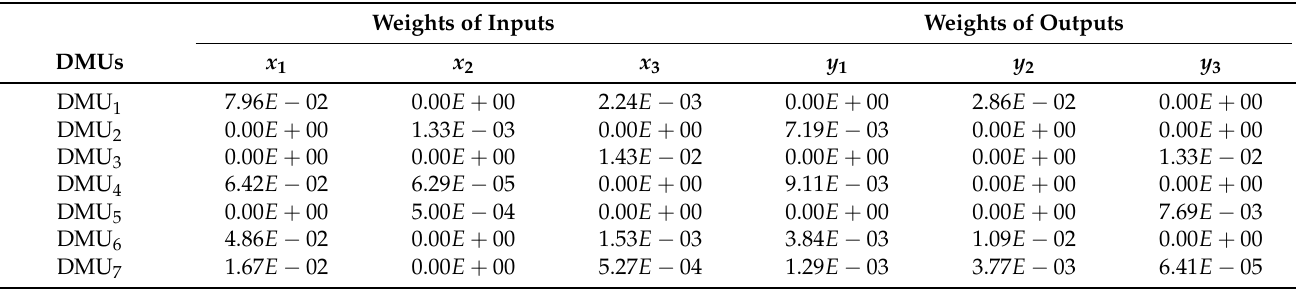
Table 2. Weights obtained from the CCR